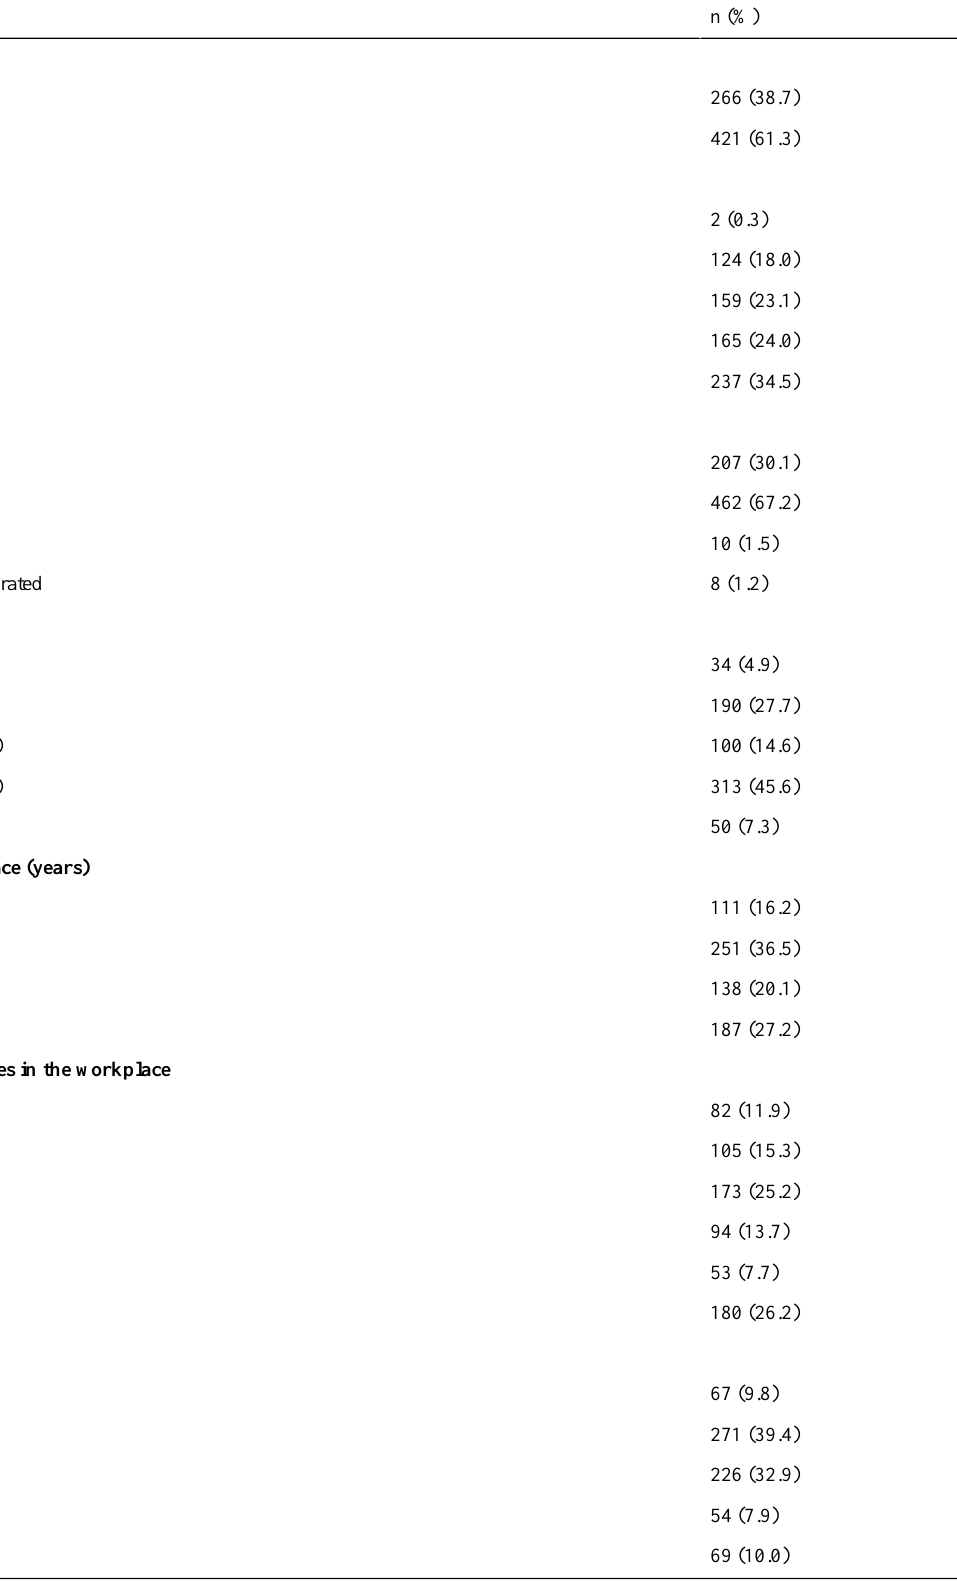
Table 2. Characteristics of the workers